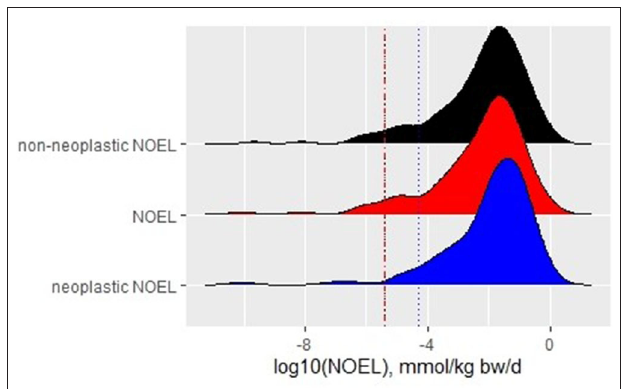
FIGURE 1 | Density plot with histograms for NOELs derived for different endpoints with fifth percentile of each distribution represented by a dotted line of the respective